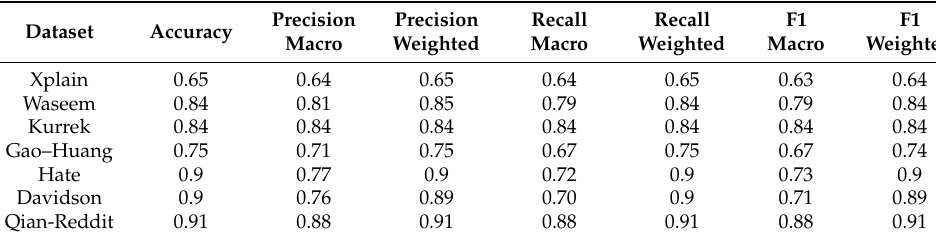
Table 4. MTL (learned parameter) RoBERTa token embeddings.